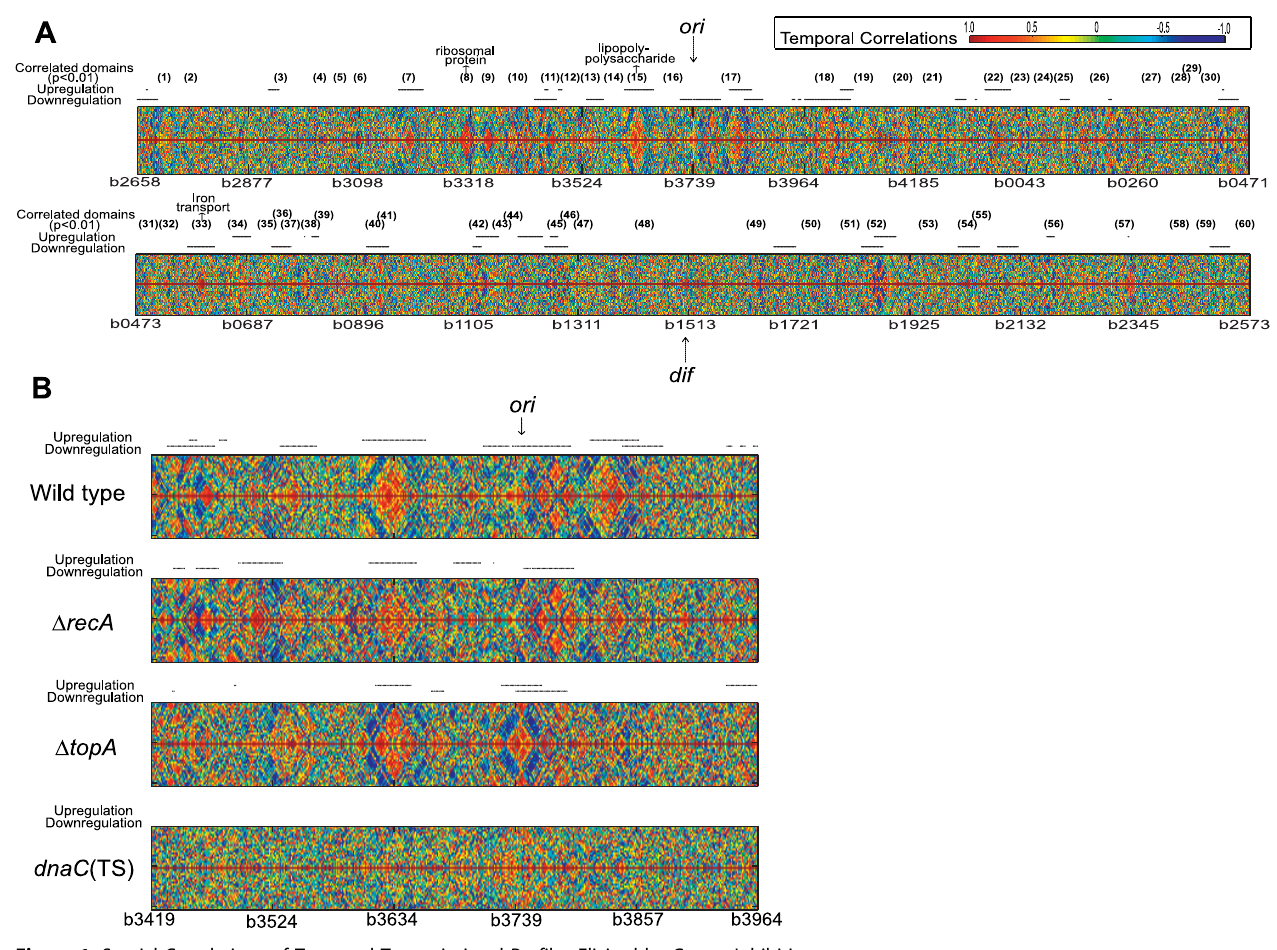
Figure 1. Spatial Correlations of Temporal Transcriptional Profiles Elicited by Gyrase Inhibition Temporal transcriptional profiles observed in the wild-type (A) and isogenic mutant strains (B). Pair-wise correlations of temporal transcript profiles of 4,000 genes, arranged in the chromosomal order, are shown on a colorimetric scale for the whole chromosome (A) and the oriC proximal region (B). For spatial correlations around the n -th gene ( n on the x -axis) in the chromosomal order, each y -axis includes 20 Pearson correlations of temporal profile pairs, ( n (cid:1) 1, n þ 1), ( n (cid:1) 2, n þ 2),...( n (cid:1) 19, n þ 19), and ( n (cid:1) 20, n þ 20). Chromosomal regions with high correlations exhibit symmetric red (positive) or blue (negative) triangles. Differentially expressed genes were significantly enriched in the regions marked with horizontal bars. The regions in which at least 16 consecutive genes show significant high correlations are enumerated. The statistical significance is estimated by the comparison with 5,000 randomly sampled subsets of temporal profiles. DOI: